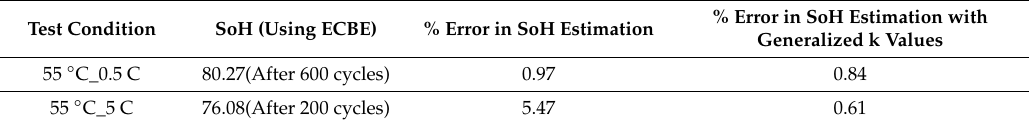
Table 11. % error in SoH estimation for the cases of 0.5 and 5 C at 55 ◦ C